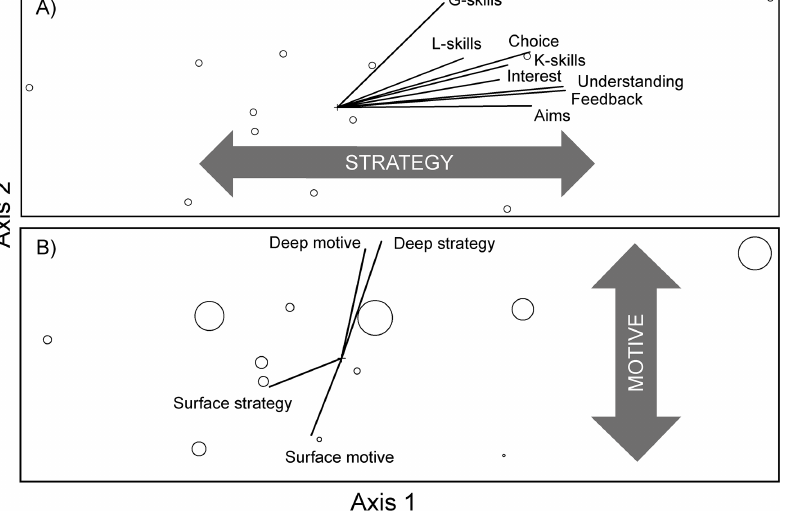
Fig 2. Twelve course sections are shown as open circles in student primary subscale space using NMS. (a) Several components of the ETL and KLA positively correlate with Axis 1, the strategy axis. Conceptual change of the ATI also correlated at the positive end of axis one, though was not included in the ordination figure. (b) The Deep and Surface approaches of the R-SPQ-2F associate with the positive and negative ends of Axis 2, the motive axis, respectively. In this panel, the relative symbol size of the 12 course sections are coded by RTOP score; high RTOP scores (i.e., larger circles) correlate with the positive end of Axis